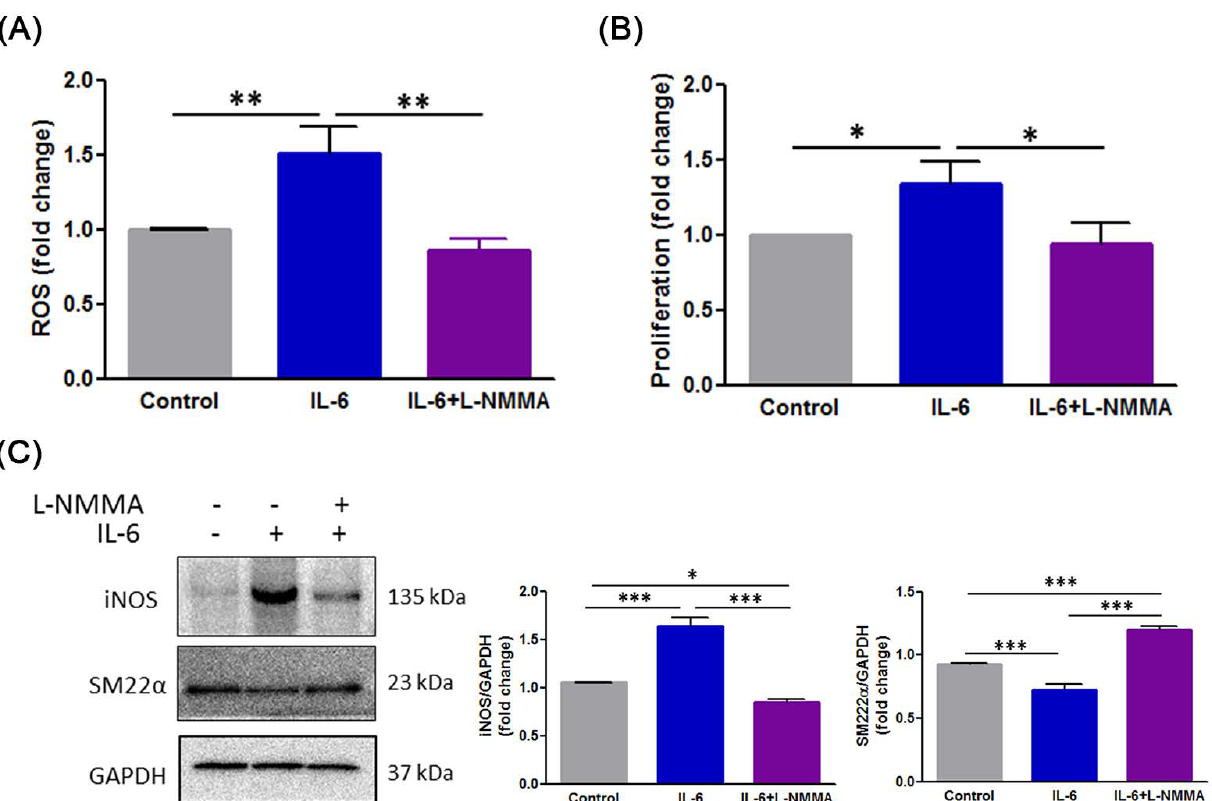
Figure 6. ROS-NO-iNOS axis governs IL-6-induced phenotypic switch in VSMCs. ( A ) The intracellular ROS level was measured using the fluorescent probe DCF-DA. ( B ) Cell proliferation was examined using a WST-1 assay. ( C ) Western blotting was performed to assess the expression of iNOS and SM22 α . GAPDH was used as a loading control. Each result represents three separate experiments with qualitatively similar results. The data are expressed as mean ± SD. Statistical significance: * p < 0.05, ** p < 0.01, *** p <